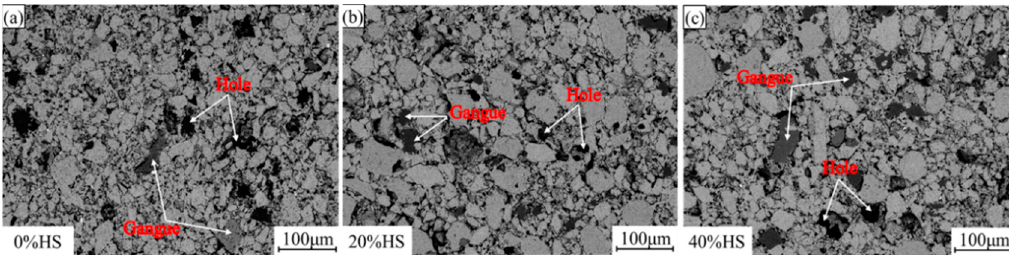
Figure 9. Scanning electron microscopy (SEM) diagrams of the oxidized pellets with different dosages of sea sand ore: ( a ) 0% HS; ( b ) 20% HS; ( c ) 40% HS.